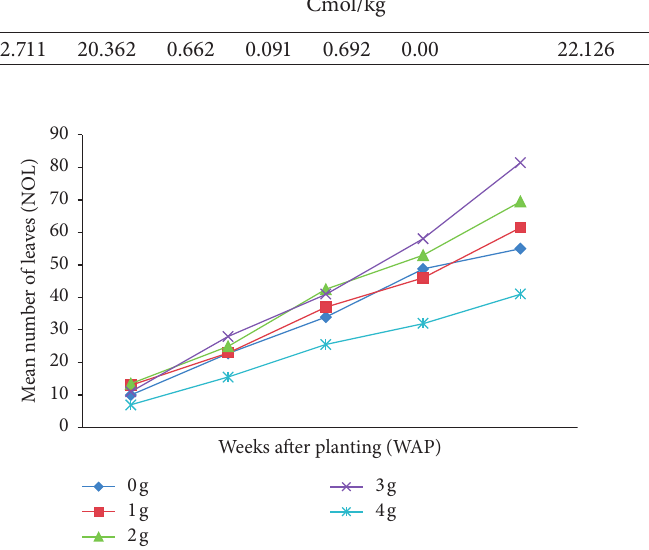
Figure 1: The mean number of leaves of Punica granatum at different treatments over 15 weeks after planting (WAP).